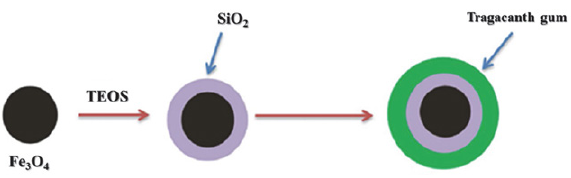
Figure 2. Schematic illustration of the procedure used for the syn- thesis of Fe 3 O 4 @SiO 2 @GT